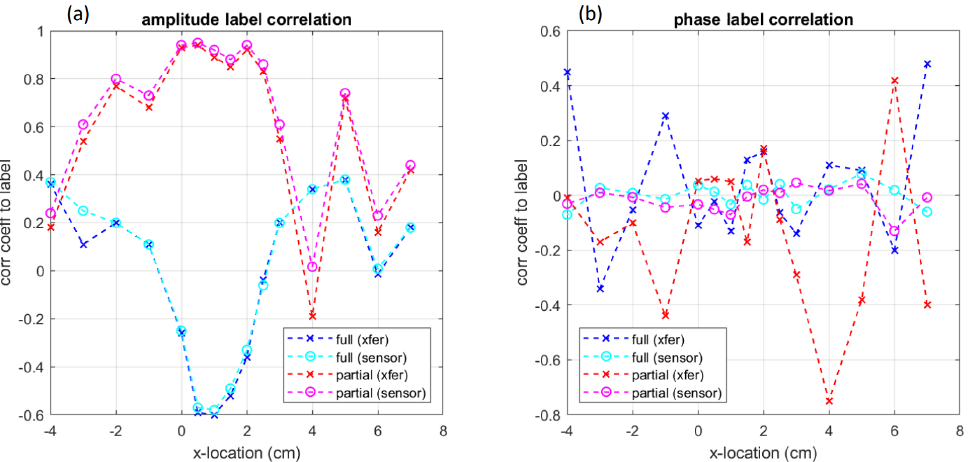
Figure 20. ( a ) Amplitude correlation to label, ( b ) phase correlation to label.